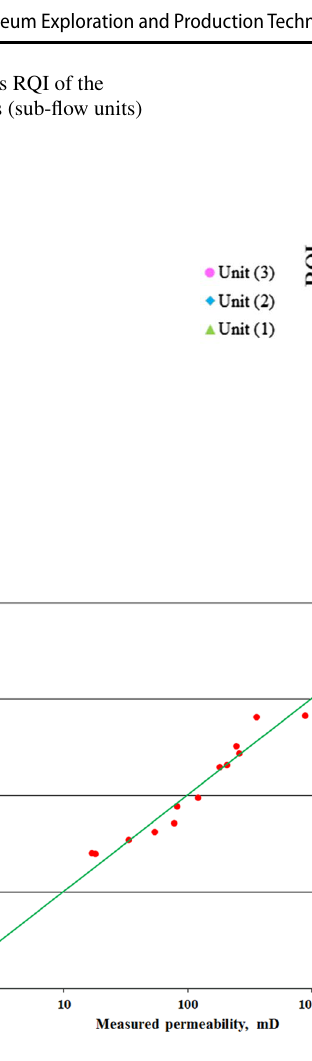
Fig. 6 Measured permeability versus predicted one using Amaefule’ approach